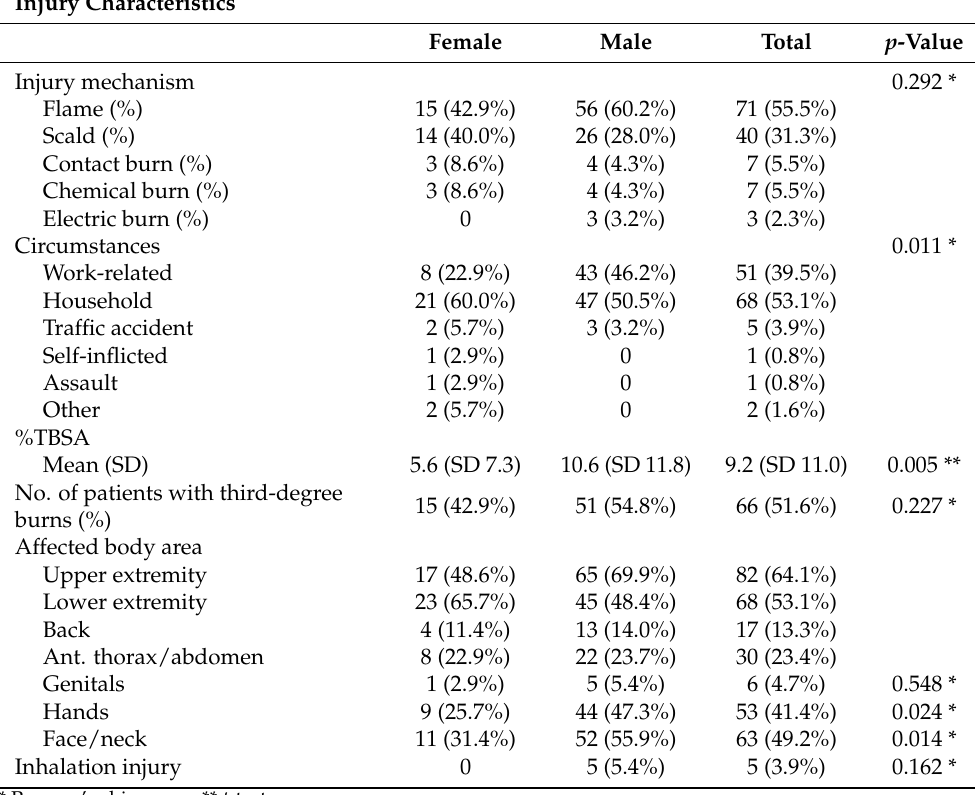
Table 3. Injury characteristics of participants.